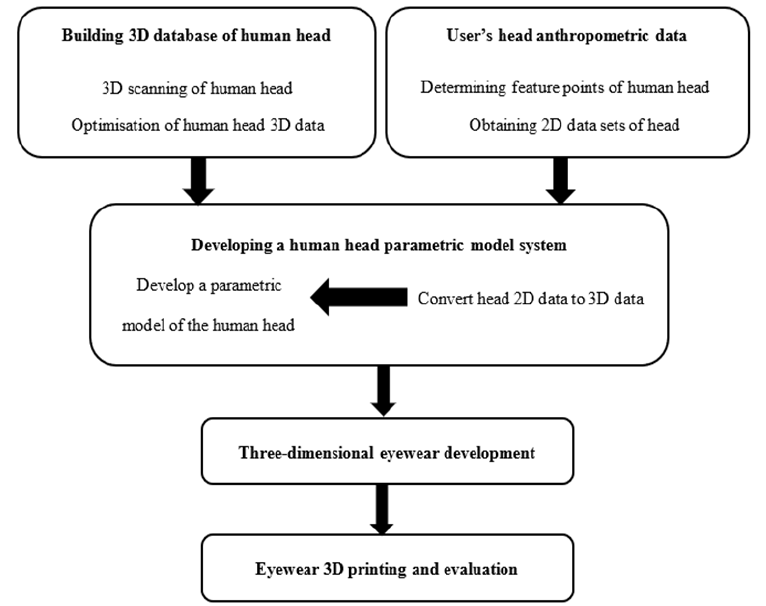
Figure 1. Parametric modelling strategy.